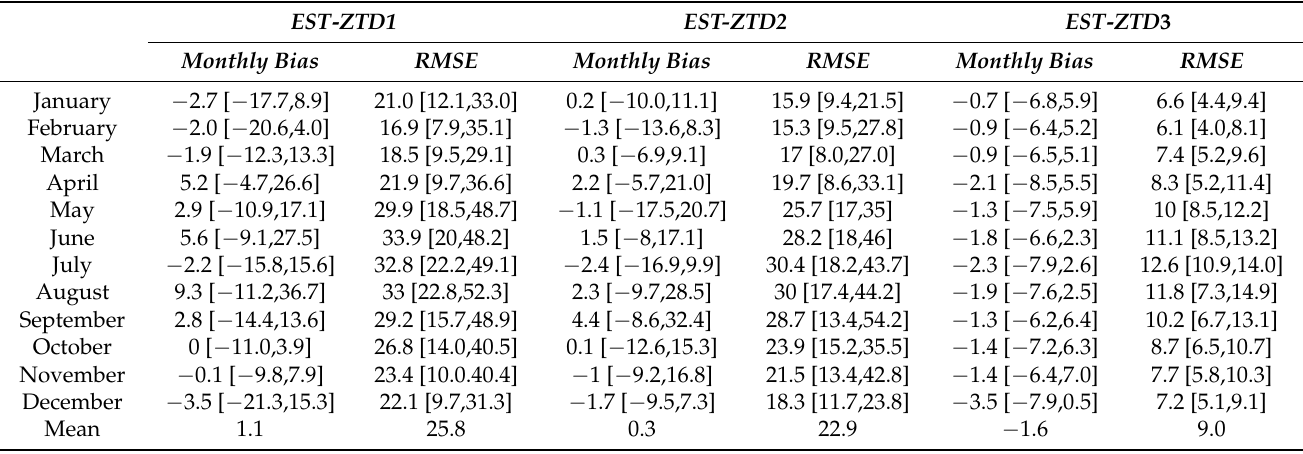
Table 3. Monthly bias and RMSE values of 10 verification stations. Values in brackets refer to the monthly minimal and maximal value for 10 verifying stations. Unit is